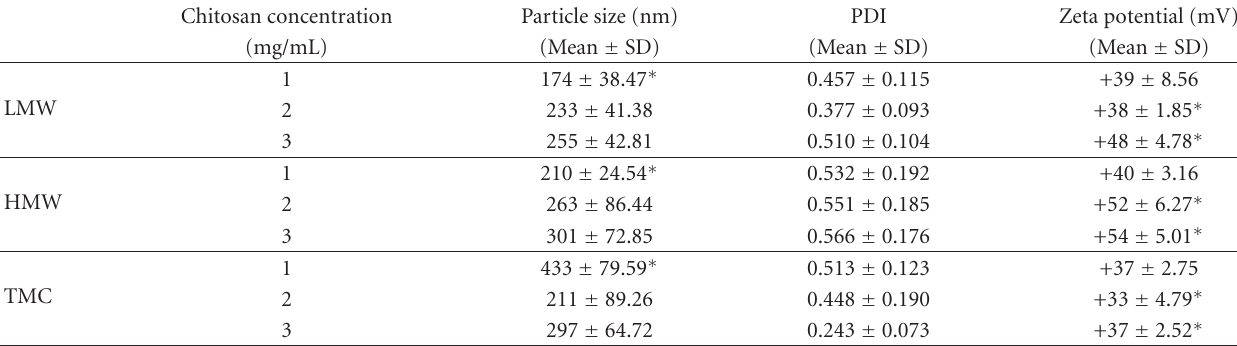
Significantly di ff erent ( P < 0 . 001) between groups for each concentration. Table 2: Mean particle size, PDI, and zeta potential of di ff erent concentration (mg/mL) for chitosan and TMC nanoparticles with constant amount of 0.1% w/v TPP after centrifugation, n =